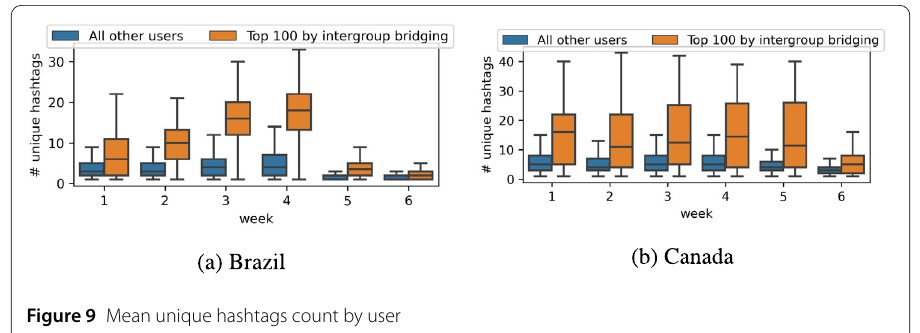
Figure 9 Mean unique hashtags count by user